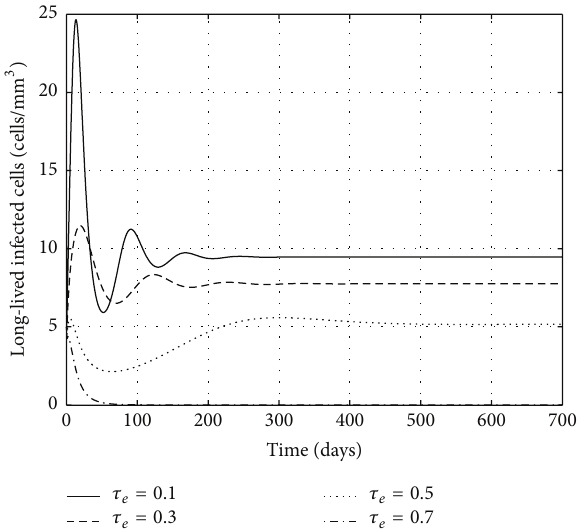
Figure 13: The concentration of long-lived chronically infected cells for model (104).